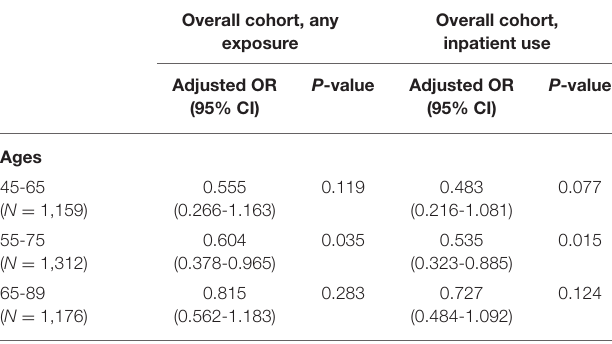
TABLE 3 | Age-stratified multivariable logistic regression analysis for COVID-19 in-hospital mortality, by alpha-1-blocker exposure (any vs. inpatient use). Overall cohort, any Overall cohort, exposure inpatient use Adjusted OR (95%